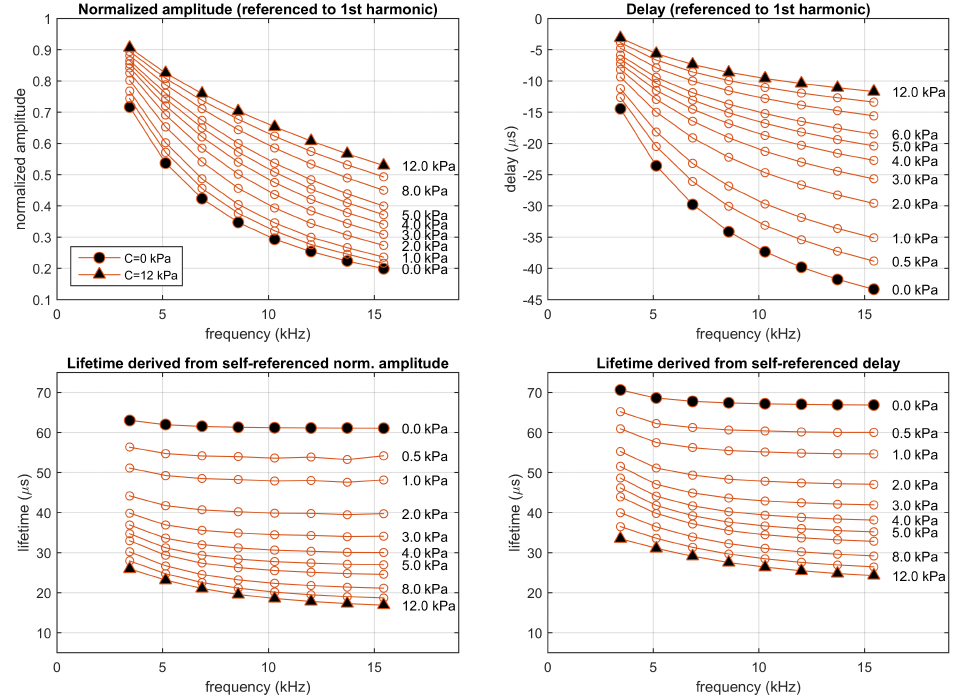
Figure 7. Simulation of the two-sites model fitting the experimental luminescent system excited in the experimental conditions (rectangular pulses presented at a fundamental frequency of 1715 Hz with a 10% duty cycle). Top panels : Normalized amplitudes and delays referenced to the first harmonic; bottom panels : corresponding self-referenced lifetimes. Each point correspond to one harmonic (from 2nd to 9th). Simulations performed at concentrations 0, 0.5, 1, 2, 3, 4, 5, 6, 8, 10, and 12